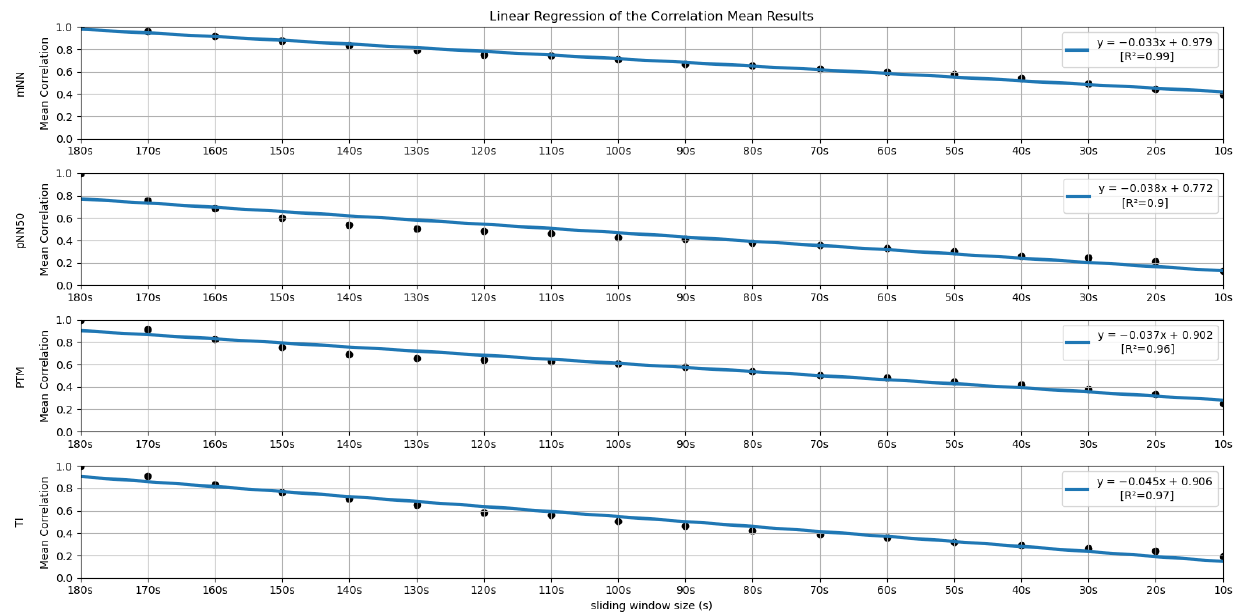
Figure 12. Linear Regressions of the Mean Correlations across runs obtained for the features mNN, pNN50, PTM and TI .